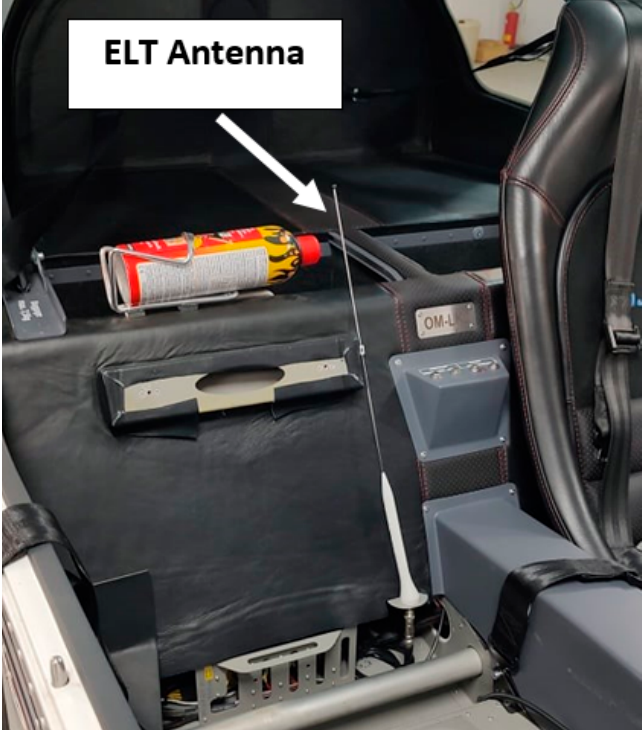
Figure 2. Location of the ELT antenna in a Tomark Aero s.r.o. Viper SD-4 RTC aircraft.